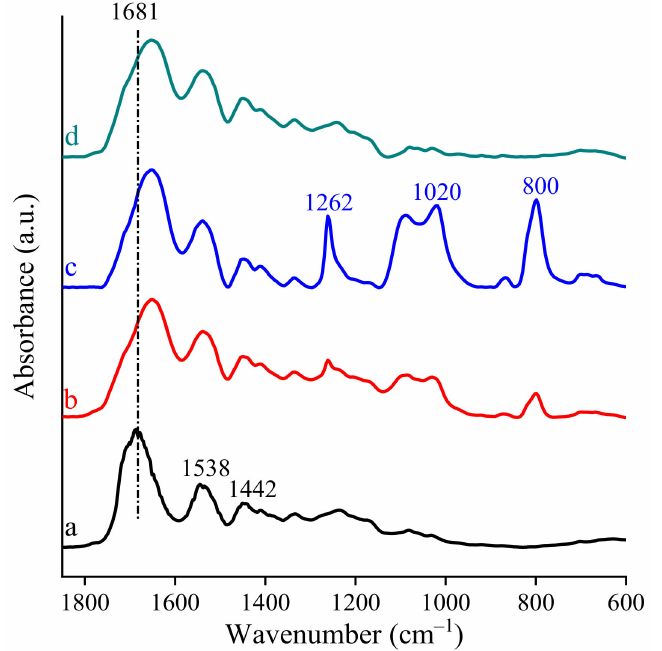
Figure 3. FTIR of nanofibrous scaffolds: ( a ) G; ( b ) GCL; ( c ) GCH and ( d ) GA. Furthermore, in the spectra of chitosan-based scaffolds, the appearance of the intense peak identified as shifted bending vibration of − OH group at about 1262 cm − 1 suggests that chitosan formed a strong chemical interaction with gelatin and/or citric acid [33]. All the scaffolds were characterized by rather similar DSC profiles (Figure